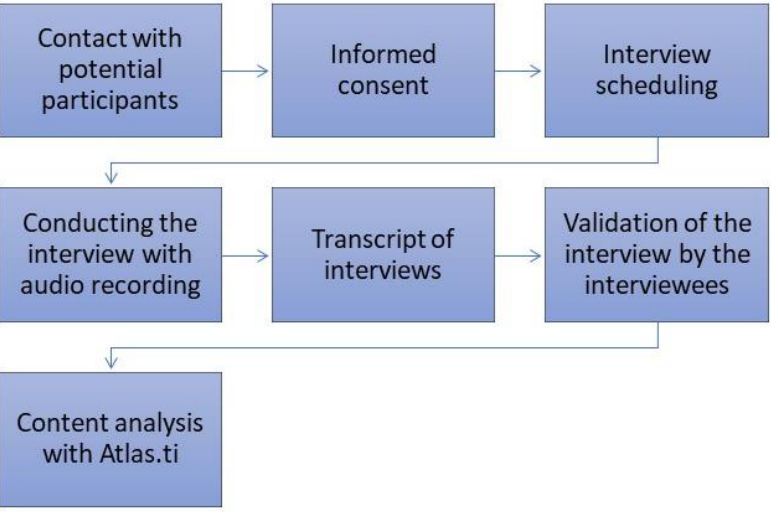
Figure 1. Method Figure 1. Method flow.